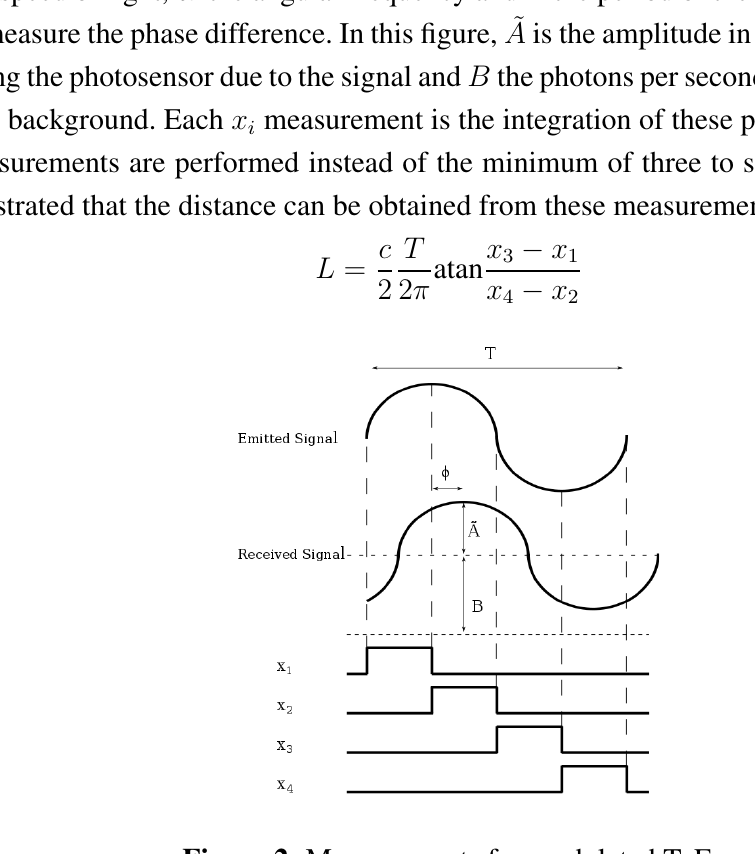
Figure 2. Measurements for modulated